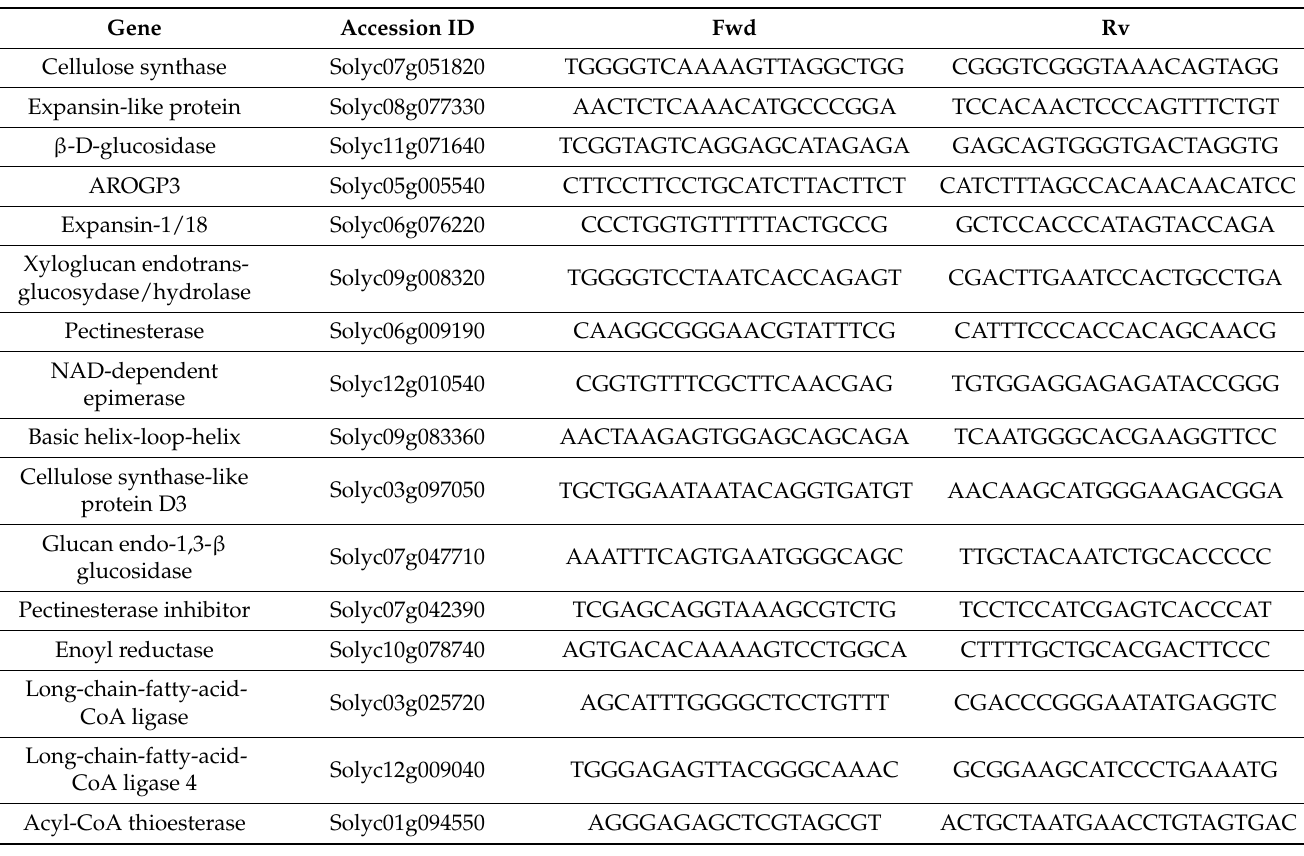
Table A1. Primers Used for qPCR of Cell Wall- and Cuticle-Related Genes.